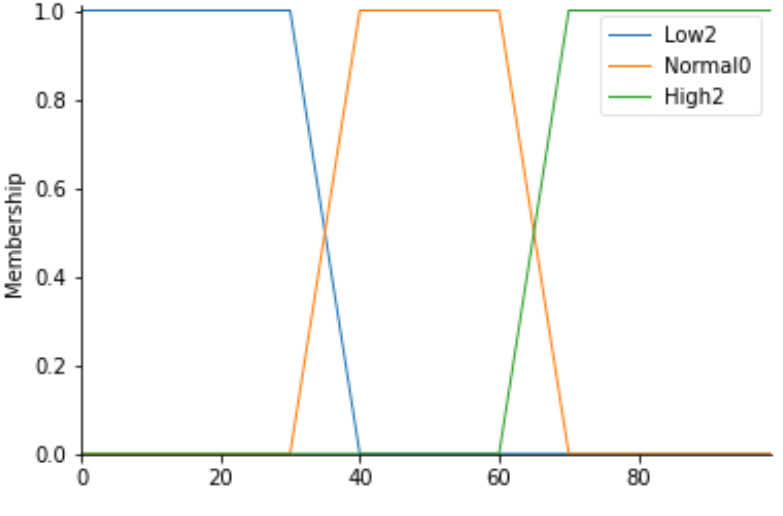
Figure 5. RH Membership functions.